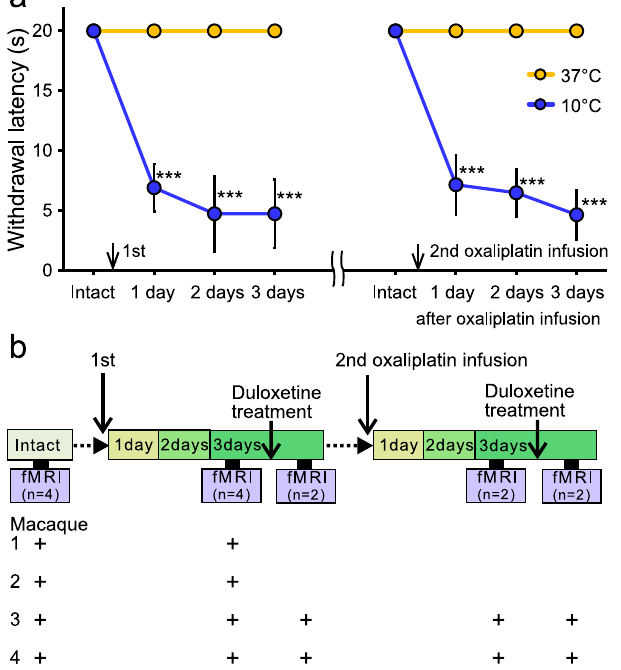
Figure 1. Cold hypersensitivity in oxaliplatin-treated macaques and fMRI study experimental design. ( a ) Effect of oxaliplatin treatment on tail withdrawal latency over time. One treatment cycle is a two week period; there were 14 days between i.v. infusions of oxaliplatin. Withdrawal latencies to a 10 °C stimulus in either the first or second cycle were significantly decreased compared with pre-infusion withdrawal latency (“Intact”). By contrast, oxaliplatin treatment did not significantly change withdrawal latency to 37 °C water. Values are expressed as mean ± SD. *** P < 0.001, compared with “Intact” (one-way repeated measures analysis of variance followed by Bonferoni’s post-hoc test). ( b ) Brain activity was assessed before (“intact”, n = 4) and 3 days after oxaliplatin infusion (n = 4), using a Philips Ingenia 3.0 T MRI system. Functional magnetic resonance imaging scans were also performed 1 hour after oral administration of duloxetine at 3 days after either the first or second infusion of oxaliplatin (n = 2). Plus signs indicate the experimental treatment of each macaque used in fMRI experiments. Macaques were sedated by continuous intravenous infusion of propofol during